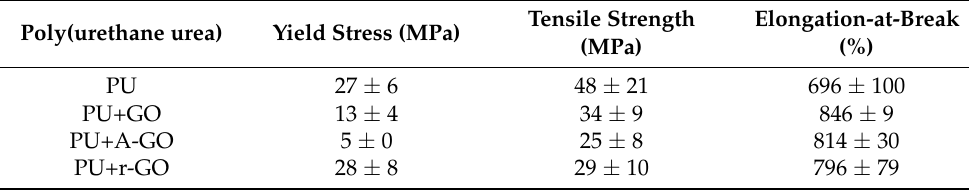
Table 11. Some mechanical properties obtained from the stress-strain curves of the PUs.